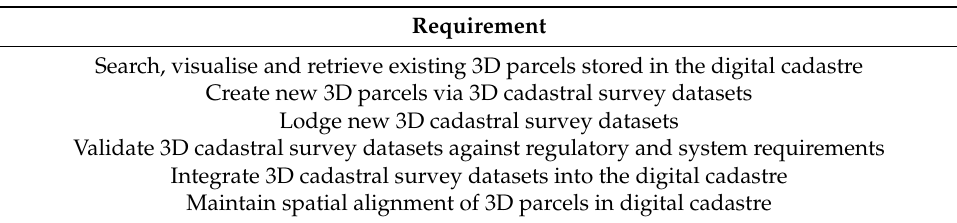
Table 1. List of fundamental requirements of 3D digital cadastre.